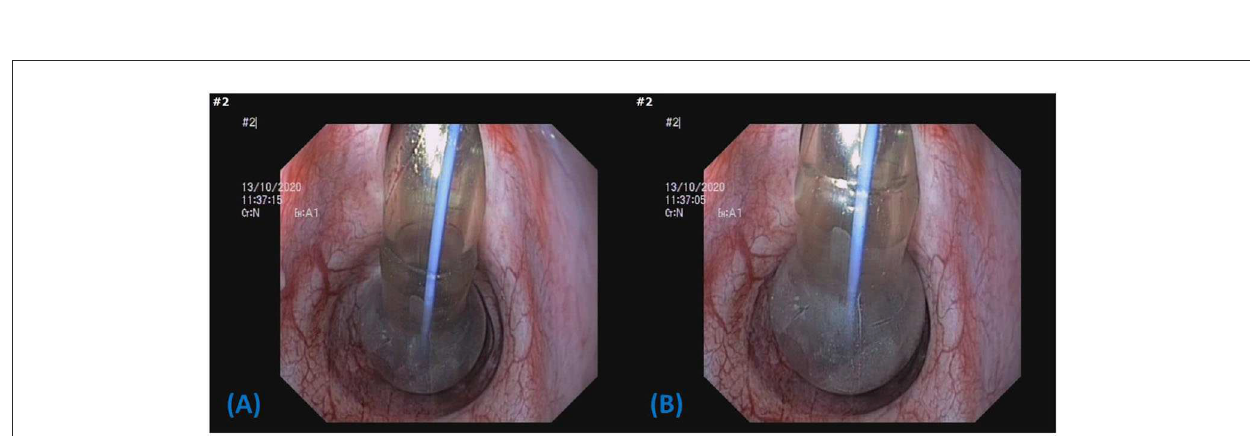
FIGURE7 Image depicting the low volume, high pressure cuff of the H&H cricothyrotomy tube in cadaver dog 2. (A) Inflated to 20cm H 2 O, (B) inflated as much as possible > 99cm H 2 O. The tube cuff contacts the airway at a single point and the IC pressure is unlikely to be transferred to the mucosa.